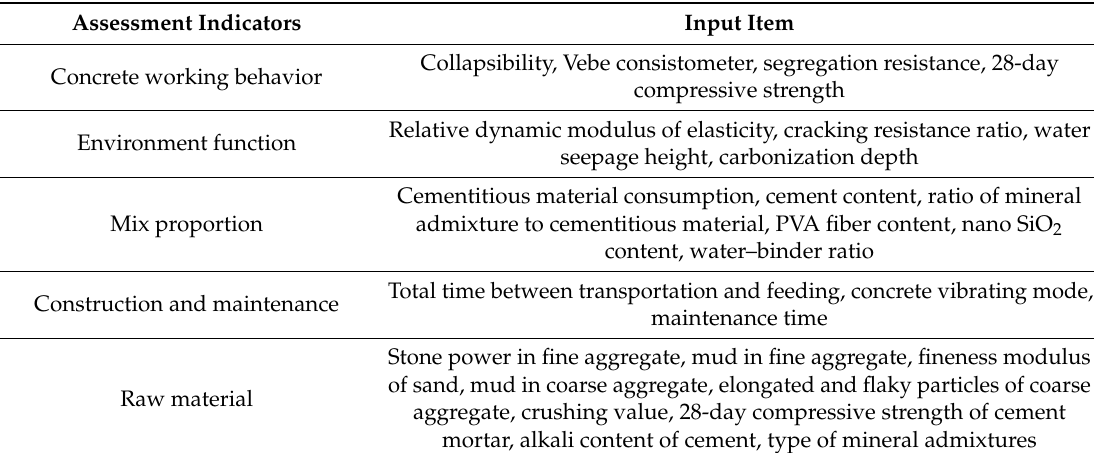
Table 2. Input items for bottom